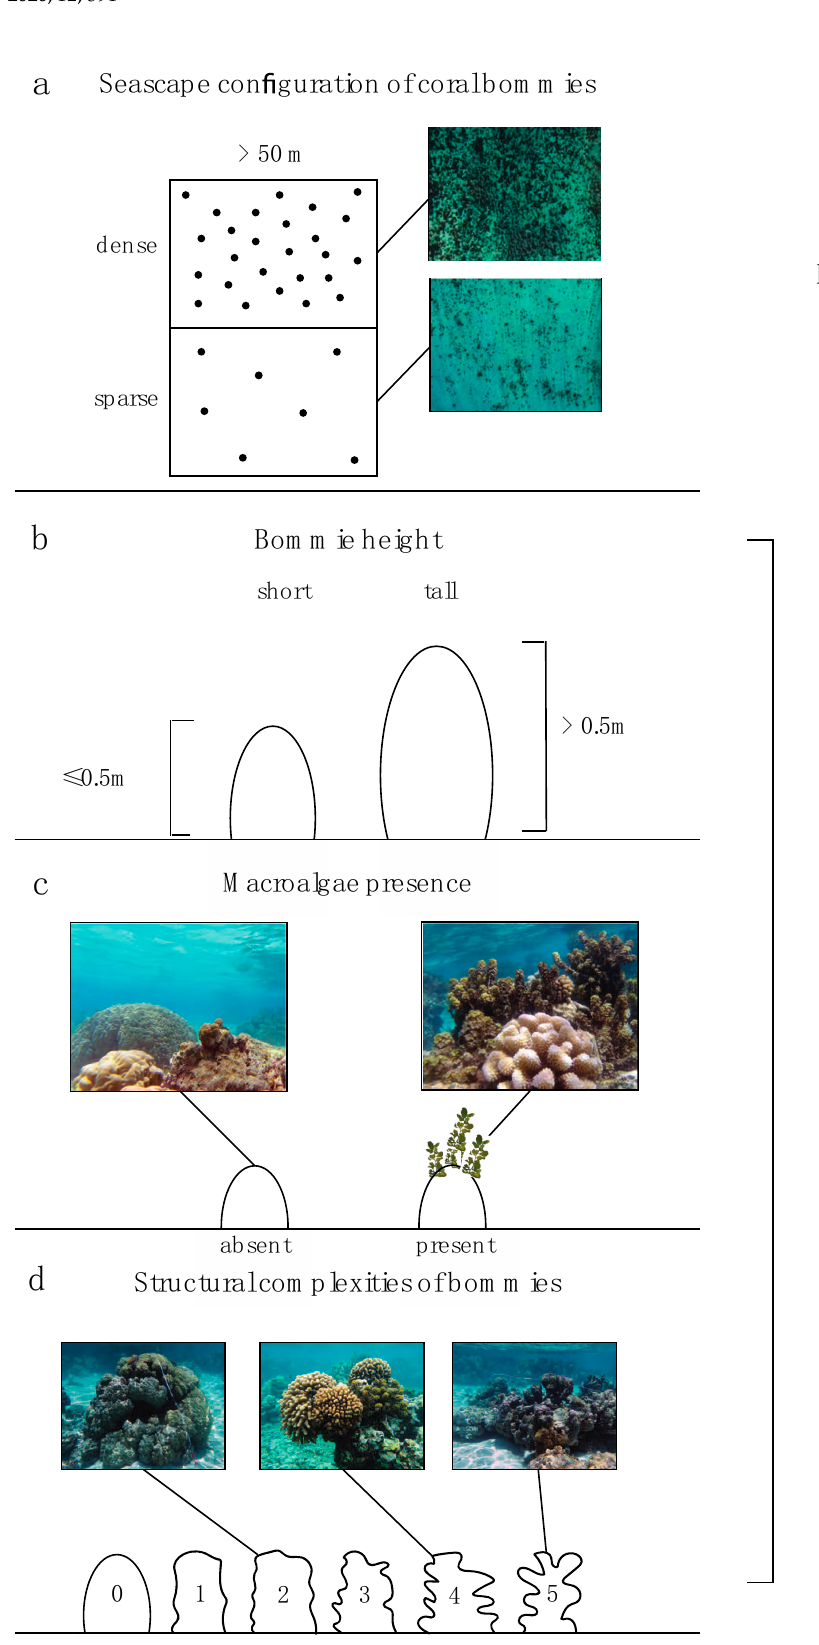
Figure 2. Complexity levels at multiple spatial scales; ( a ) broad scale configuration of coral bommies in the seascape (n dense = 42 and n sparse = 44), ( b ) height of bommies (n short = 42 and n tall = 44), ( c ) presence or absence of macroalgae on the bommie structure (n absent = 43 and n present = 43) ( d ) fine-scale structural complexity of bommies (n 2 = 5, n 3 = 27, n 4 = 22, n 5 =